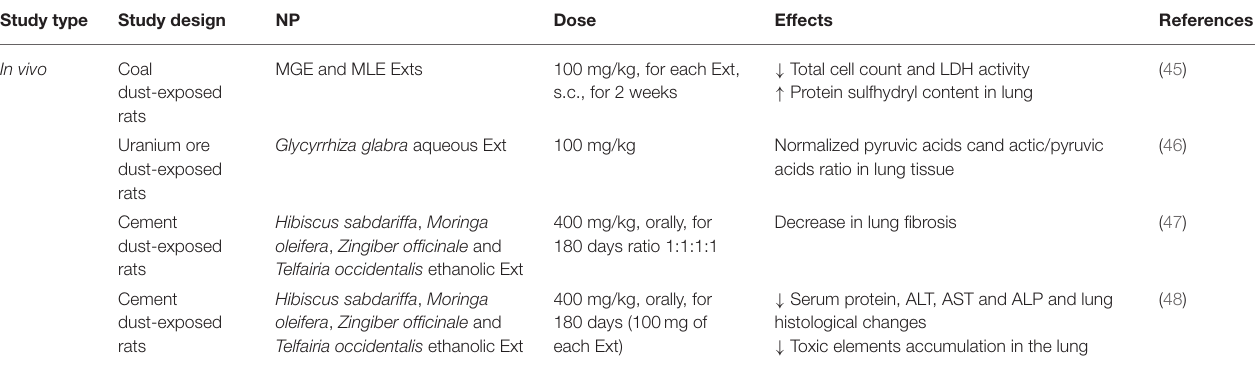
TABLE 3 | The possible therapeutic effects of medicinal herbs in the dust-induced lung disorders in experimental